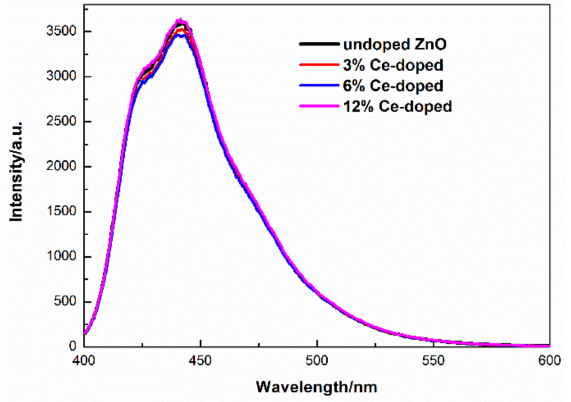
Figure 7. PL of un- and different Ce-doped ZnO films ( λ ex = 375 nm).